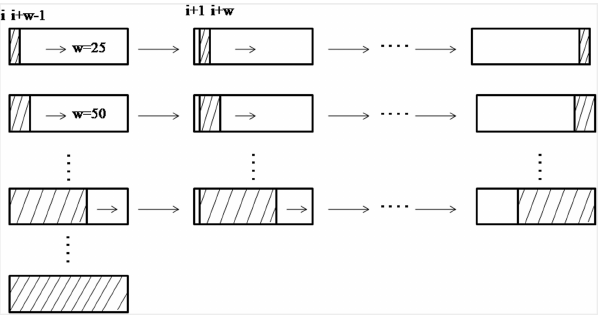
Fig. 1. The speci¯c process of CSMWPLS